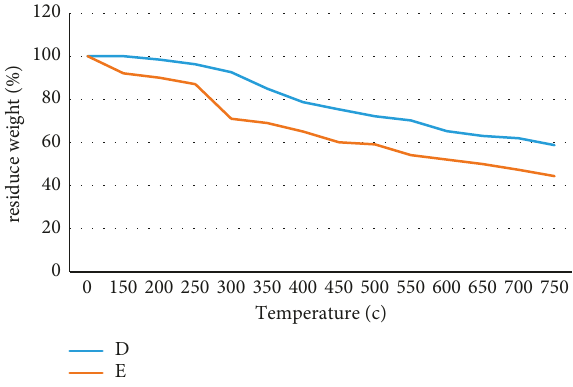
Figure 13: Comparison of thermal stability of